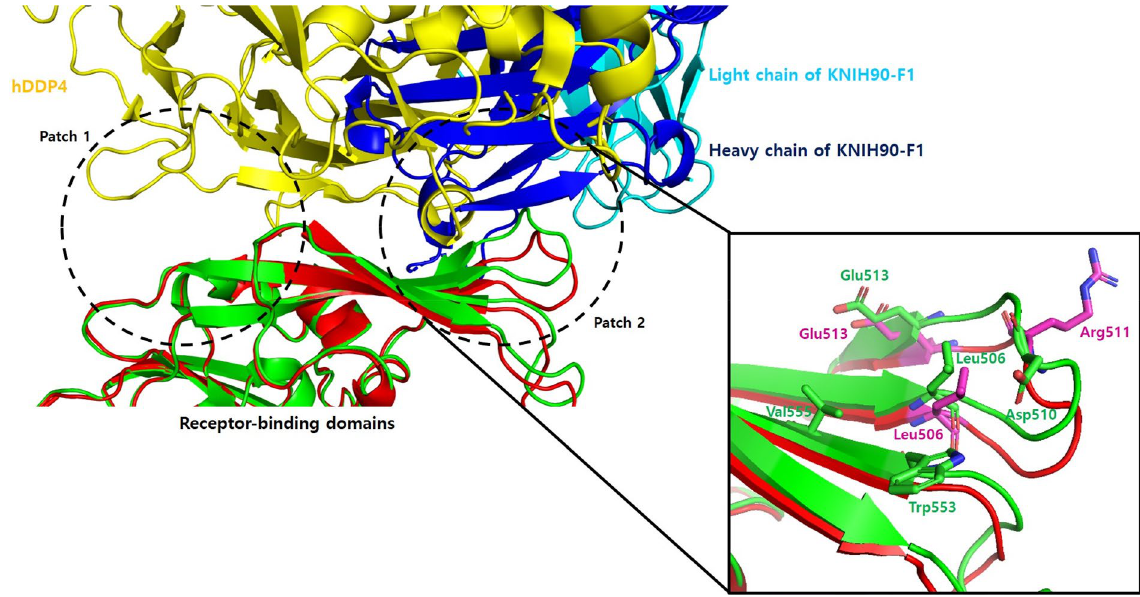
Figure 6. Binding interfaces of MERS-CoV RBD in the complex of hDDP4 (in green) and KNIH90-F1 (in red). hDDP4 interacts with MERS-CoV RBD in patch 1 and 2, while KNIH90-F1 interacts with MERS-CoV RBD in patch 2. Two residues of RBD (L506 and E513) in the binding interface with hDDP4 are overlapped with the epitopes of